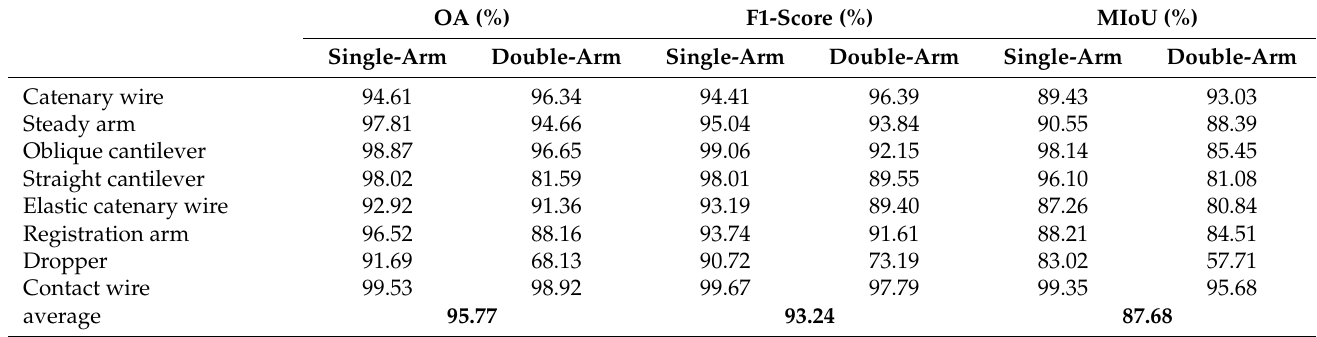
Table 3. Precision evaluation comparison of the OCS dataset semantic segmentation. The overall accuracy evaluation of the two scenes is shown in